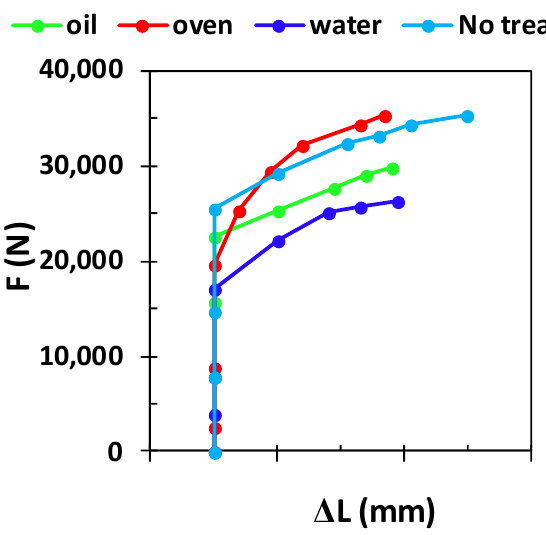
Figure 7. Force-elongation curves of tested samples .